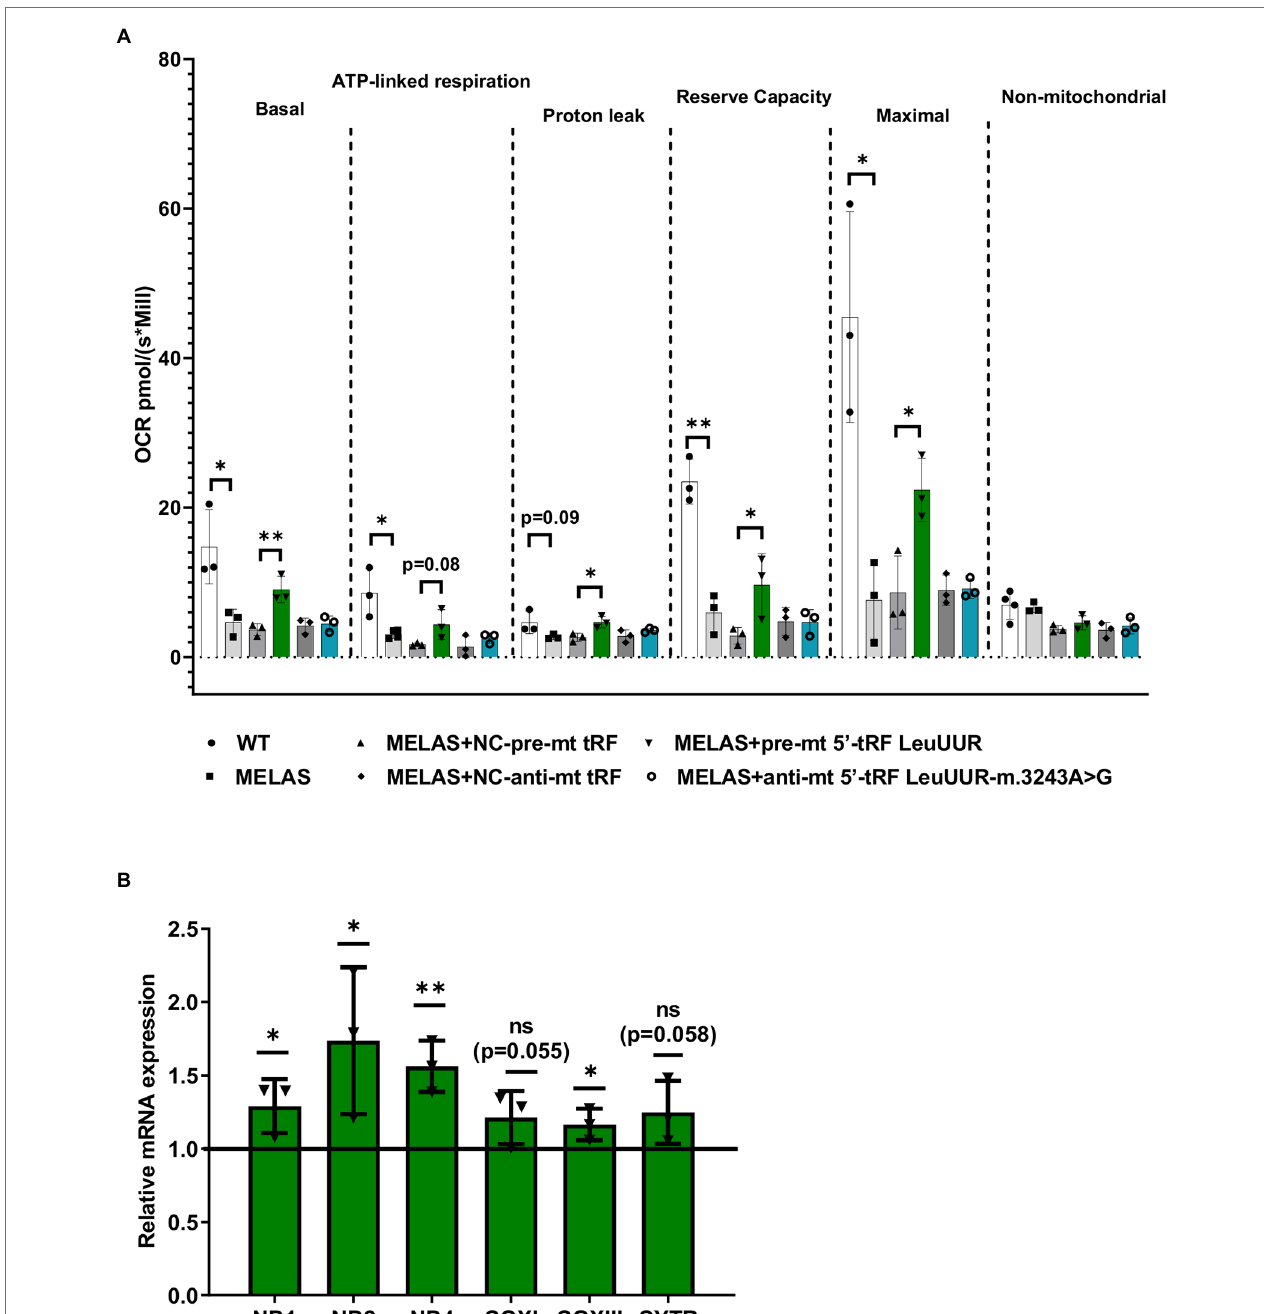
FIGURE 3 | Over-expression of mt tRNA LeuUUR fragment (mt 5 ′ -tRF LeuUUR) increases mitochondrial respiration in MELAS cybrids. (A) Analysis of oxygen consumption rate (OCR) of WT and MELAS cybrids, and MELAS cybrids transfected with an oligonucleotide mimic of mt-tRNA LeuUUR fragment (mt 5 ′ -tRF LeuUUR), an oligonucleotide antisense against mt-tRNA LeuUUR-m.3243A>G fragment (mt 5 ′ -tRF LeuUUR-m.3243A>G) and their respective controls. OCR was measured under basal conditions and after sequential addition of different OXPHOS inhibitors: oligomycin, carbonyl cyanide p-trifluoromethoxyphenylhydrazone (CCCP), rotenone, and antimycin A. The scatter plot shows basal OCR (determined as the difference between OCR before oligomycin and OCR after rotenone/ antimycin incorporation A), ATP-linked OCR (difference between OCR before and after oligomycin), proton leak (difference between basal OCR and ATP-linked OCR), reserve capacity (difference between the CCCP-stimulated rate and basal OCR), non-mitochondrial OCR (OCR after rotenone and antimycin A treatment), and maximal OCR (difference between OCR after CCCP and non-mitochondrial OCR). (B) RT-qPCR analysis of the expression of ND1 , ND2 , ND4, COXI, COXIII , and CYTB mRNAs in MELAS cybrids transfected with an oligonucleotide mimic of mt-tRNA LeuUUR fragment (mt 5 ′ -tRF LeuUUR) with respect to negative control- transfected cells. Data are represented as fold change respect to values from control samples. The horizontal bar represents the media value for control samples. Differences from control values were found to be statistically significant at * p < 0.05 and ** p <